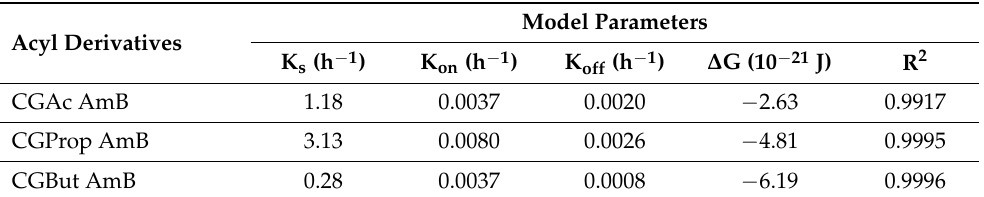
Table 2. Second order exponential order parameters for AmB-loaded acylated cashew gum derivative nanoparticles.